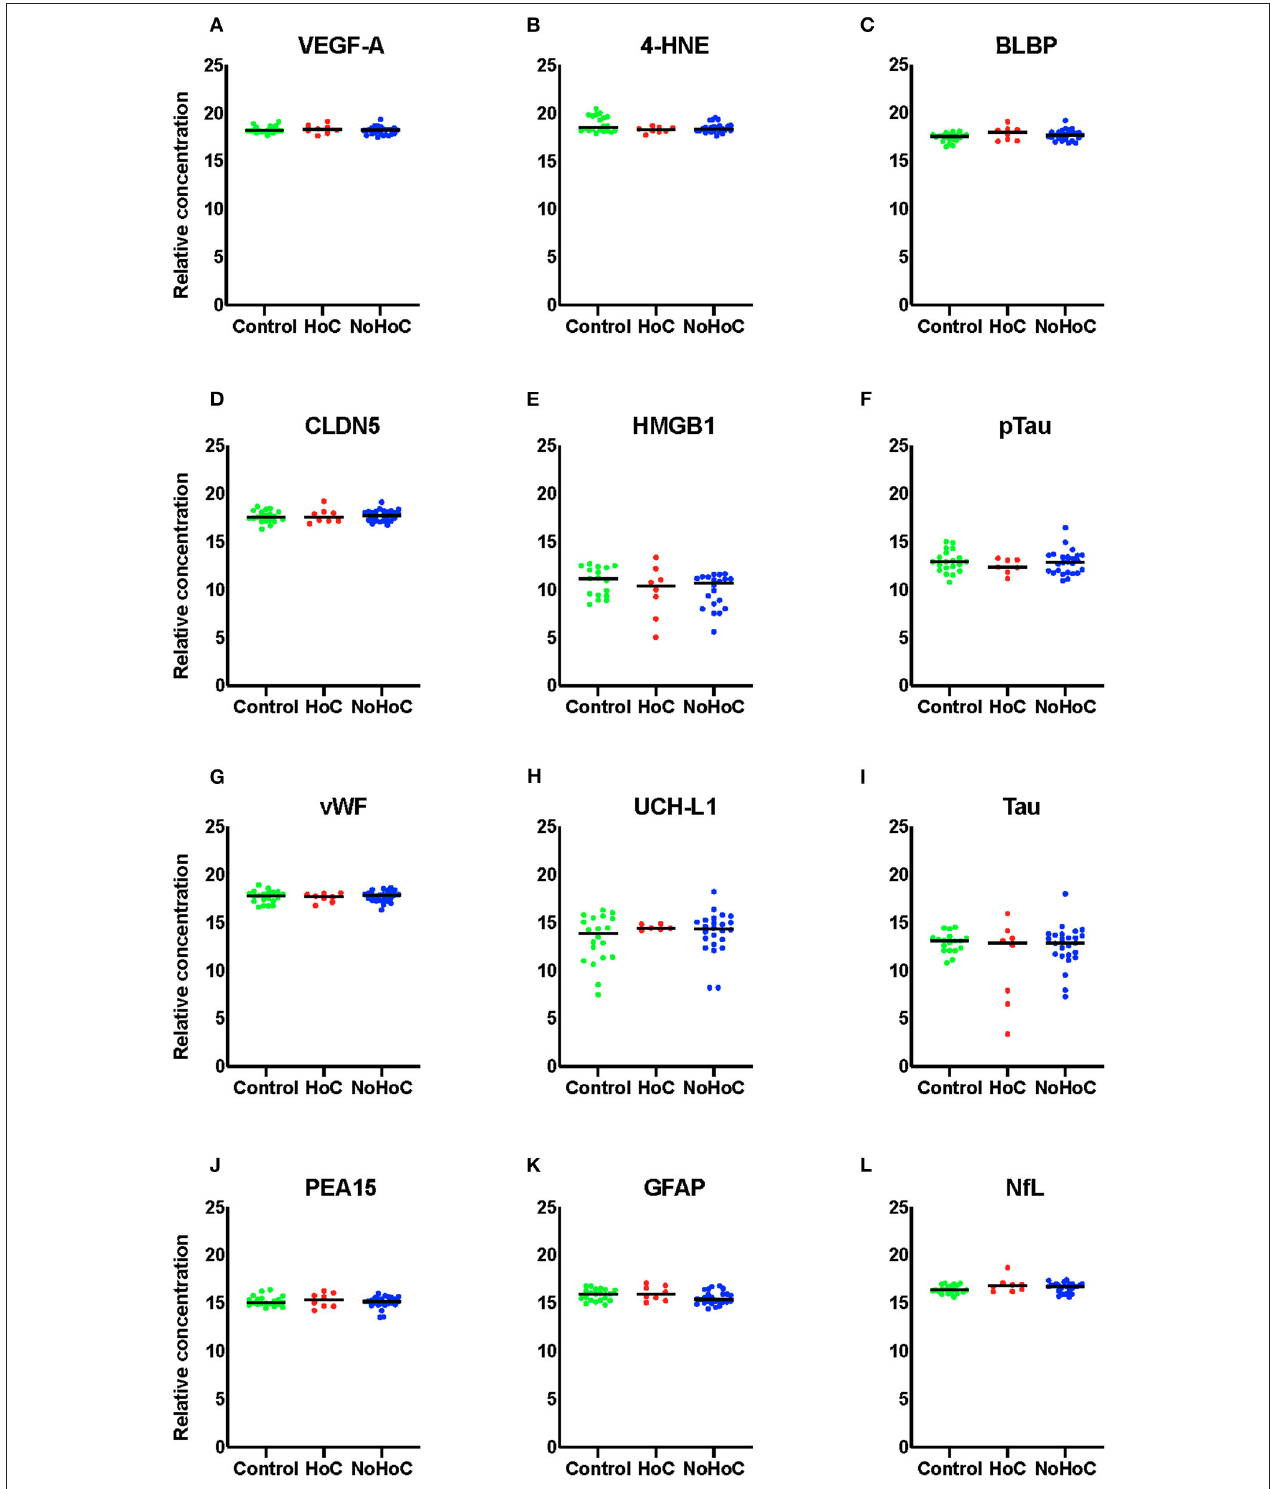
FIGURE 2 | Serum protein levels in female samples of (A) VEGF-A, (B) 4-HNE, (C) BLBP, (D) CLDN5, (E) HMGB1, (F) pTau, (G) vWF, (H) UCH-L1, (I) Tau, (J) PEA-15, (K) GFAP, and (L) NfL. There were no significant findings on any of the markers.